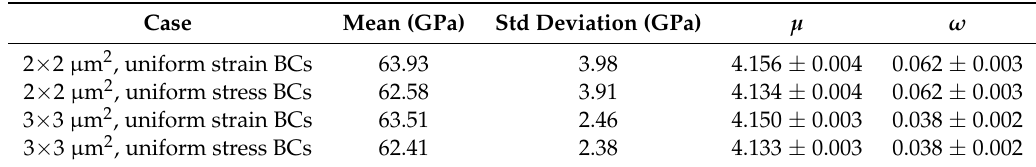
Table 2. Shear modulus G : apparent values of the mean and standard deviation obtained with the MC analysis and parameters for the lognormal CDFs in Equation (6).